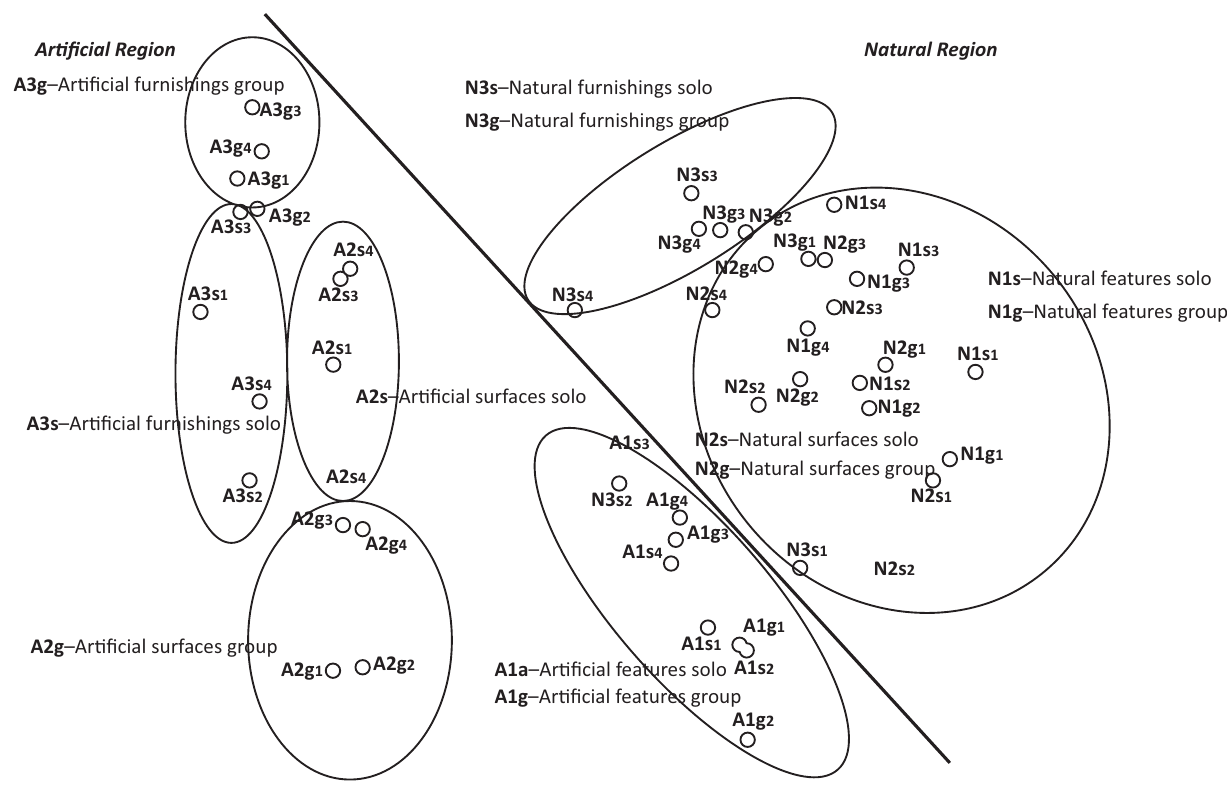
Figure 2. Two-dimensional spatial representation of 48 items (stress = 0.07; N =